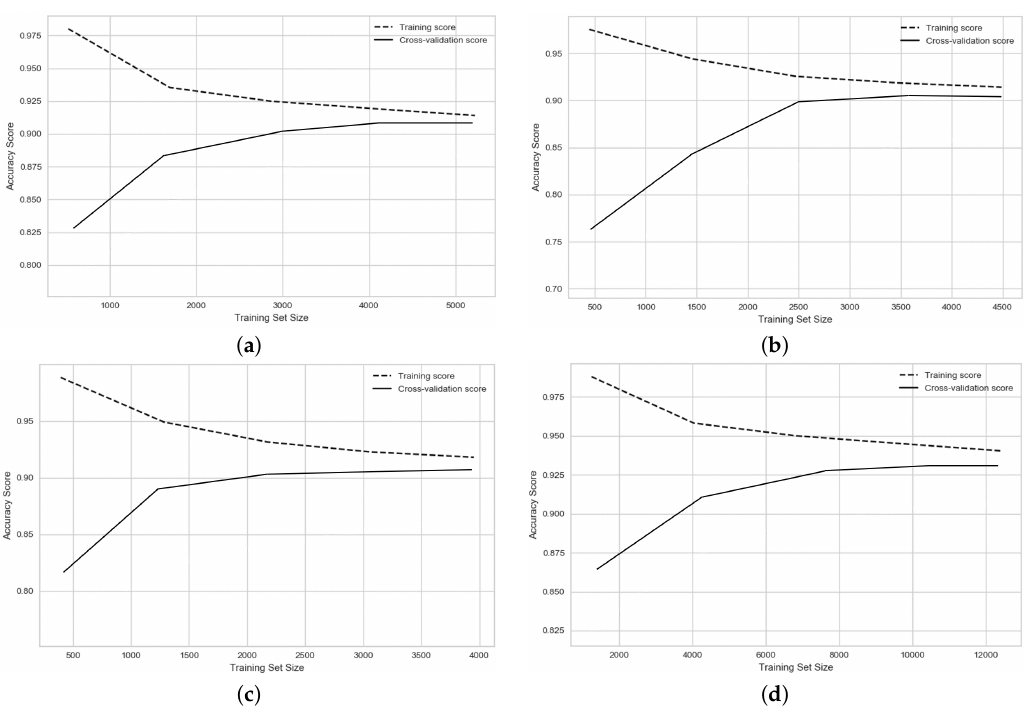
Figure 8. Learning Curves for SDAE model: ( a ) Isfahan, ( b ) Enschede, ( c ) Tehran, and ( d ) Paris.